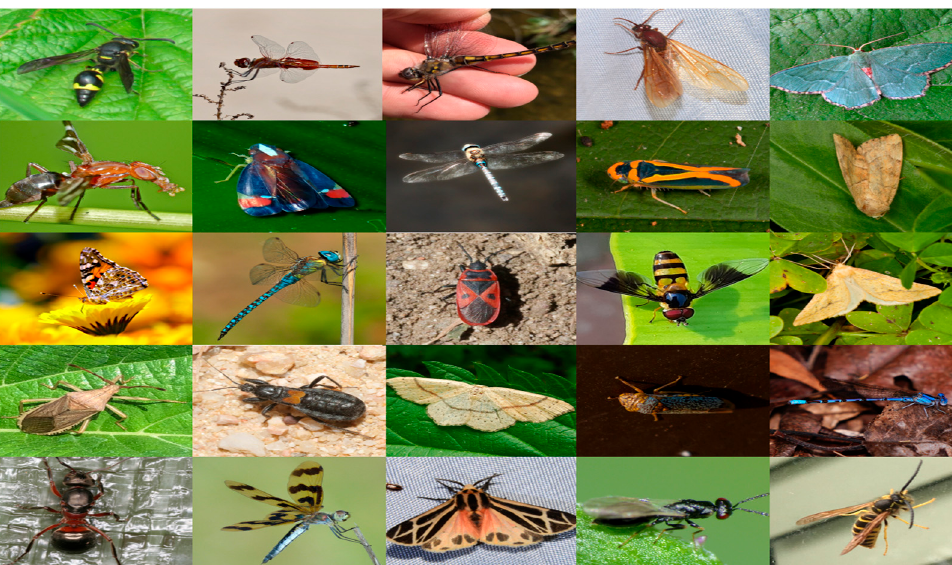
Figure 1. Images of Insect pests used in training and validation of object detection models.